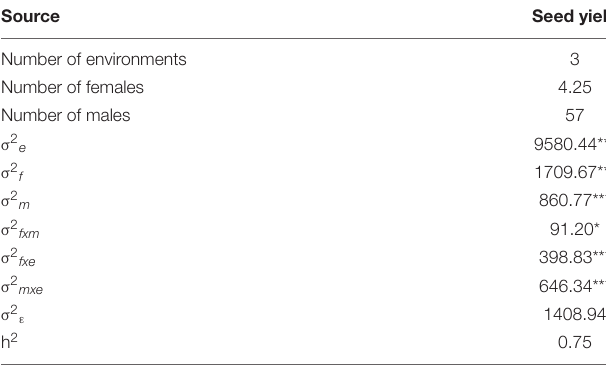
TABLE 2 | Variance components underlying phenotypic variation of the sterility level and its broad-sense heritability (h 2 ) using raw and curated data of the hybrid seed production experiment.